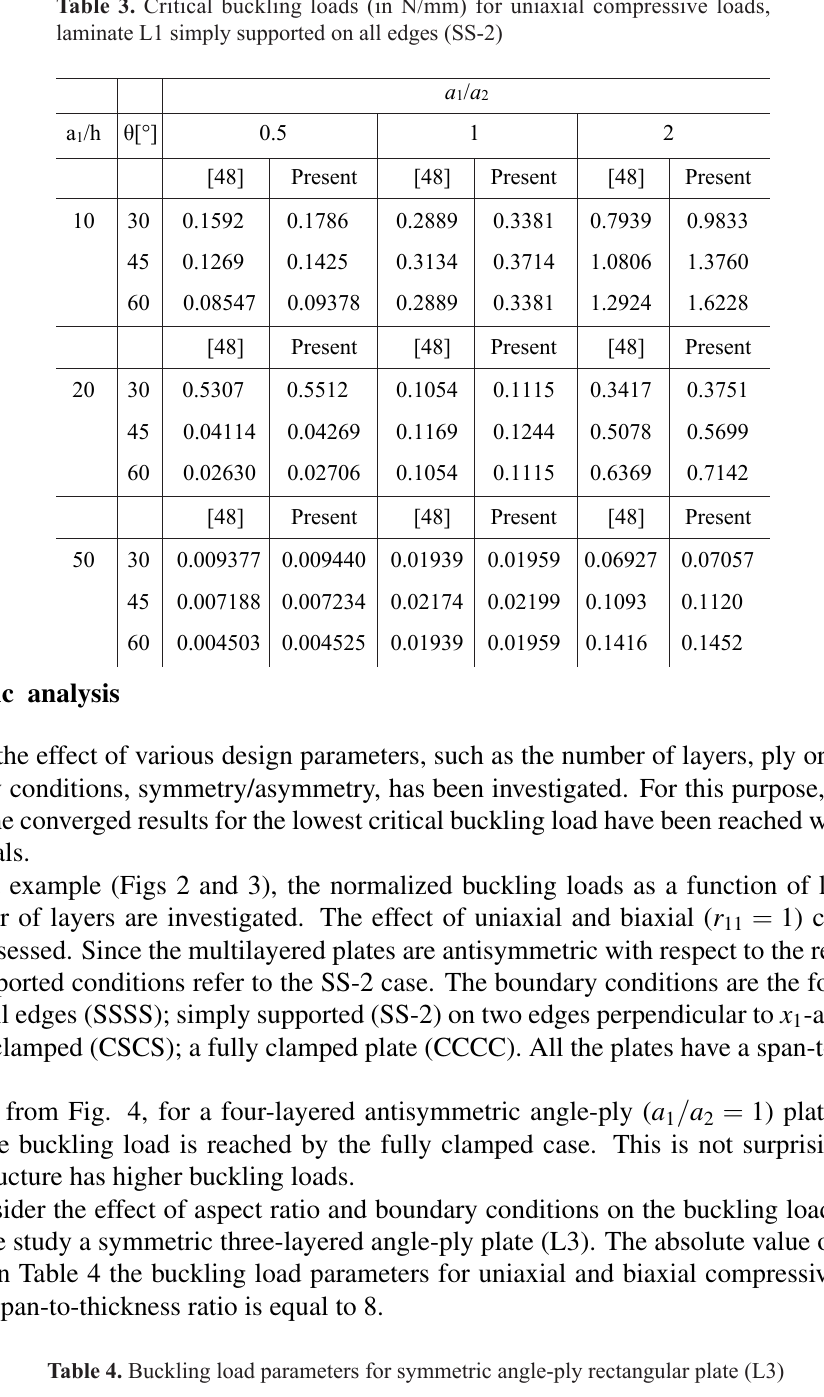
Table 4. Buckling load parameters for symmetric angle-ply rectangular plate